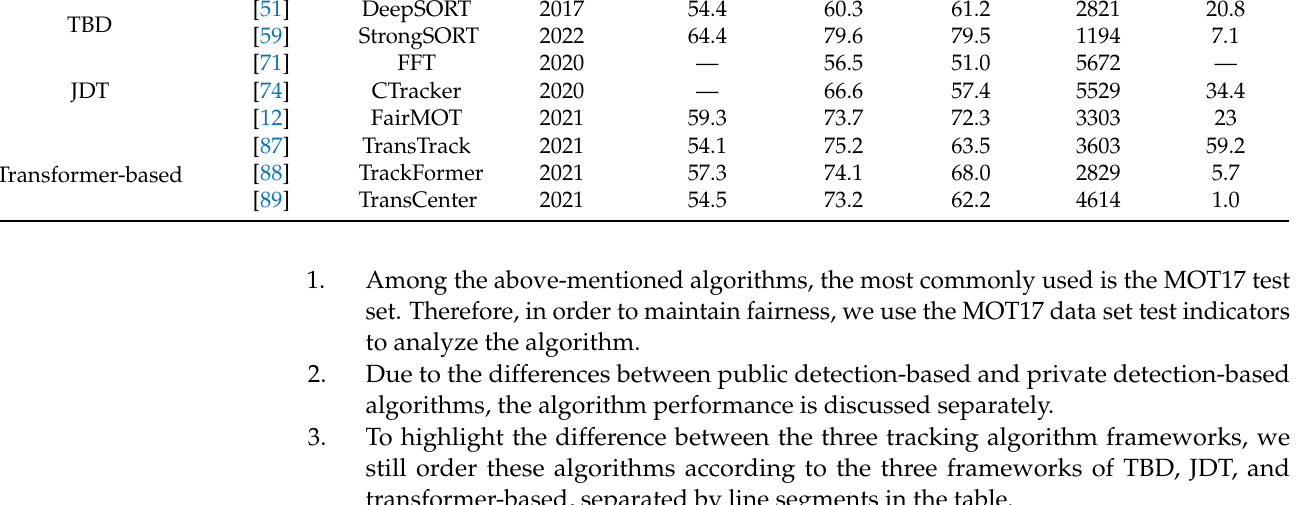
Table 9. In the MOT17 dataset [25], the algorithm evaluation index based on the private detector. Framework